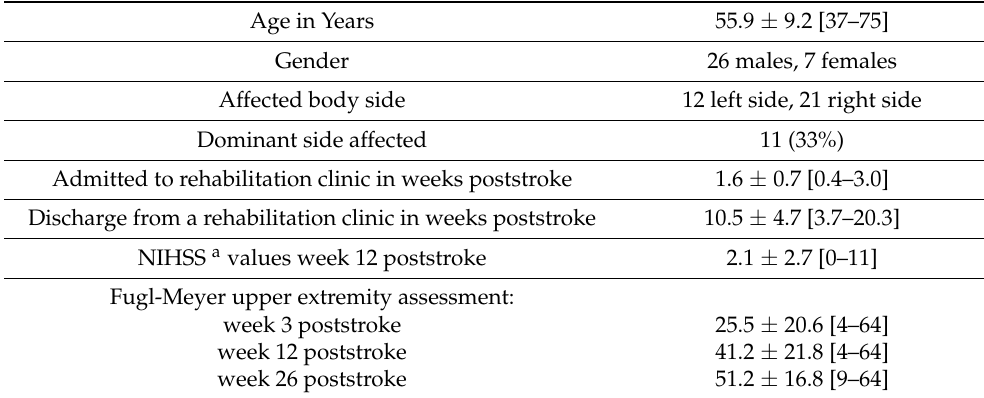
Table 1. Patient characteristics (n = 33). Data are reported as mean ± SD [minimal value, maximal value] unless otherwise stated.